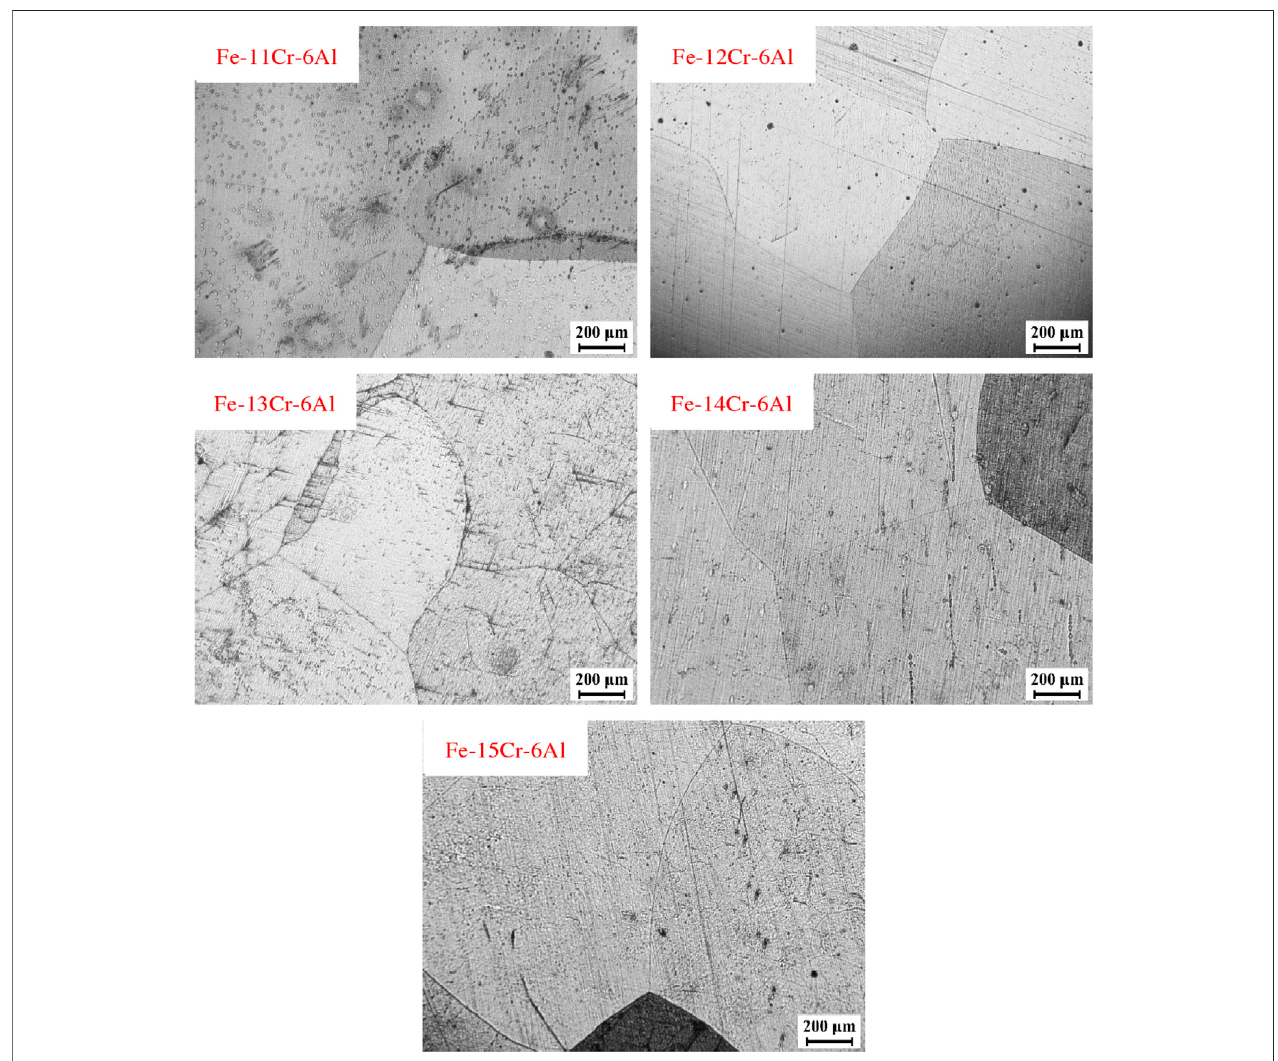
FIGURE 5 | As-cast structure of Fe – x Cr – 6Al alloy with different Cr